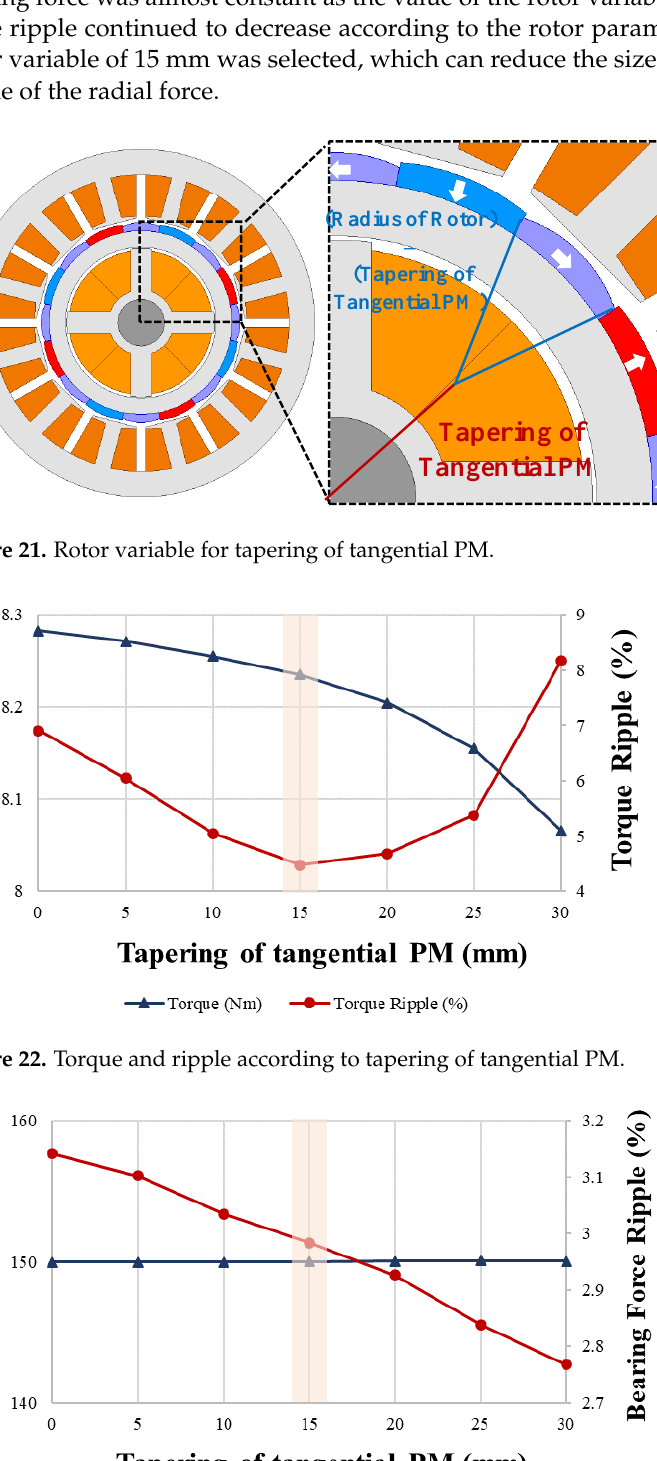
Figure 23. Bearing force and ripple according to tapering of tangential PM.